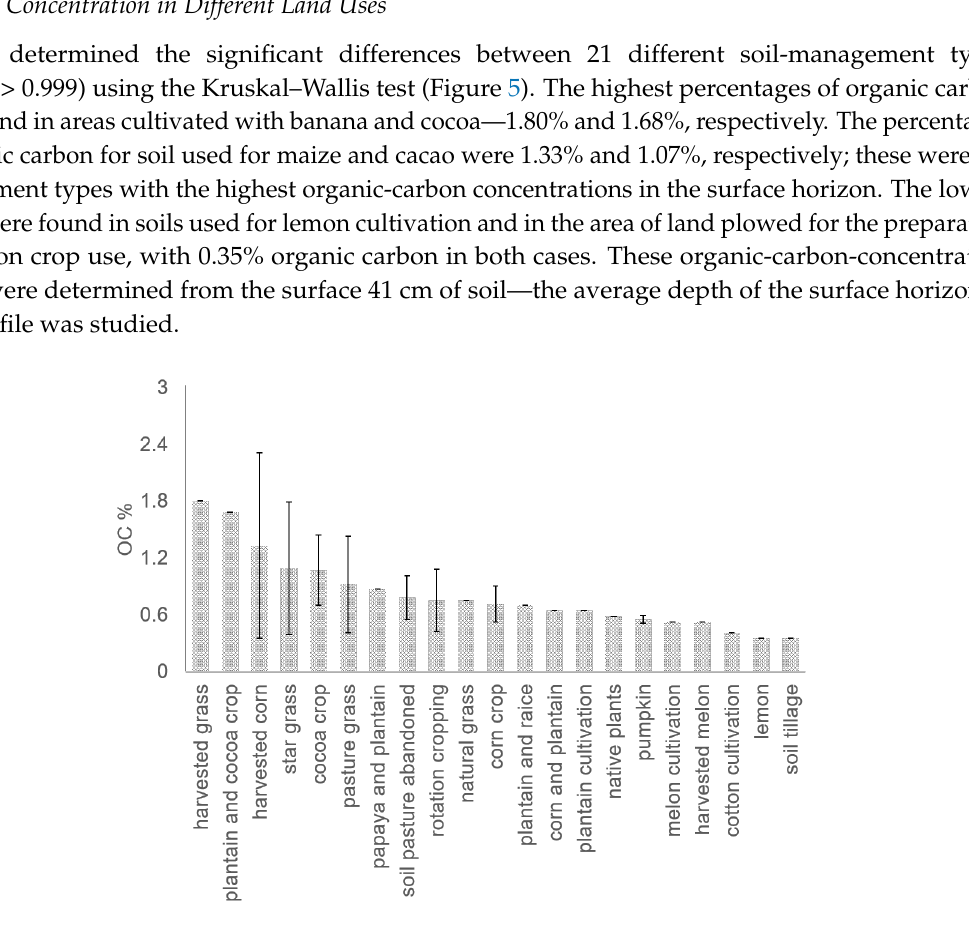
Figure 5. SOC concentration in % only in the surface horizon (Hz1). Different letters indicate significant differences based on soil land use according to the Kruskal–Wallis test, ( p < 0.05).